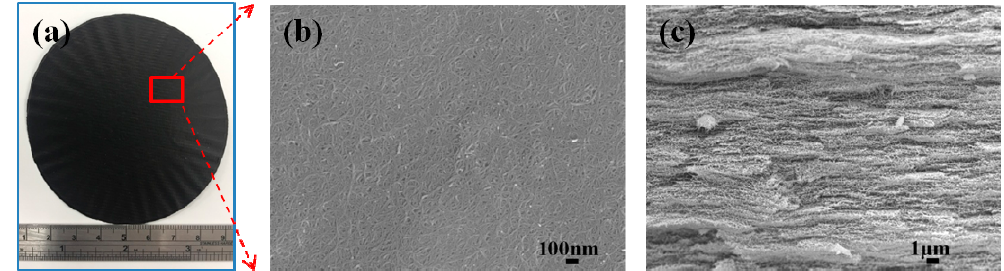
Figure 4. GNP-0 film with 0 wt% graphene and 100 wt% MWCNT; ( a ) the prepared film, ( b ) surface morphology SEM image, and ( c ) cross-section SEM image.